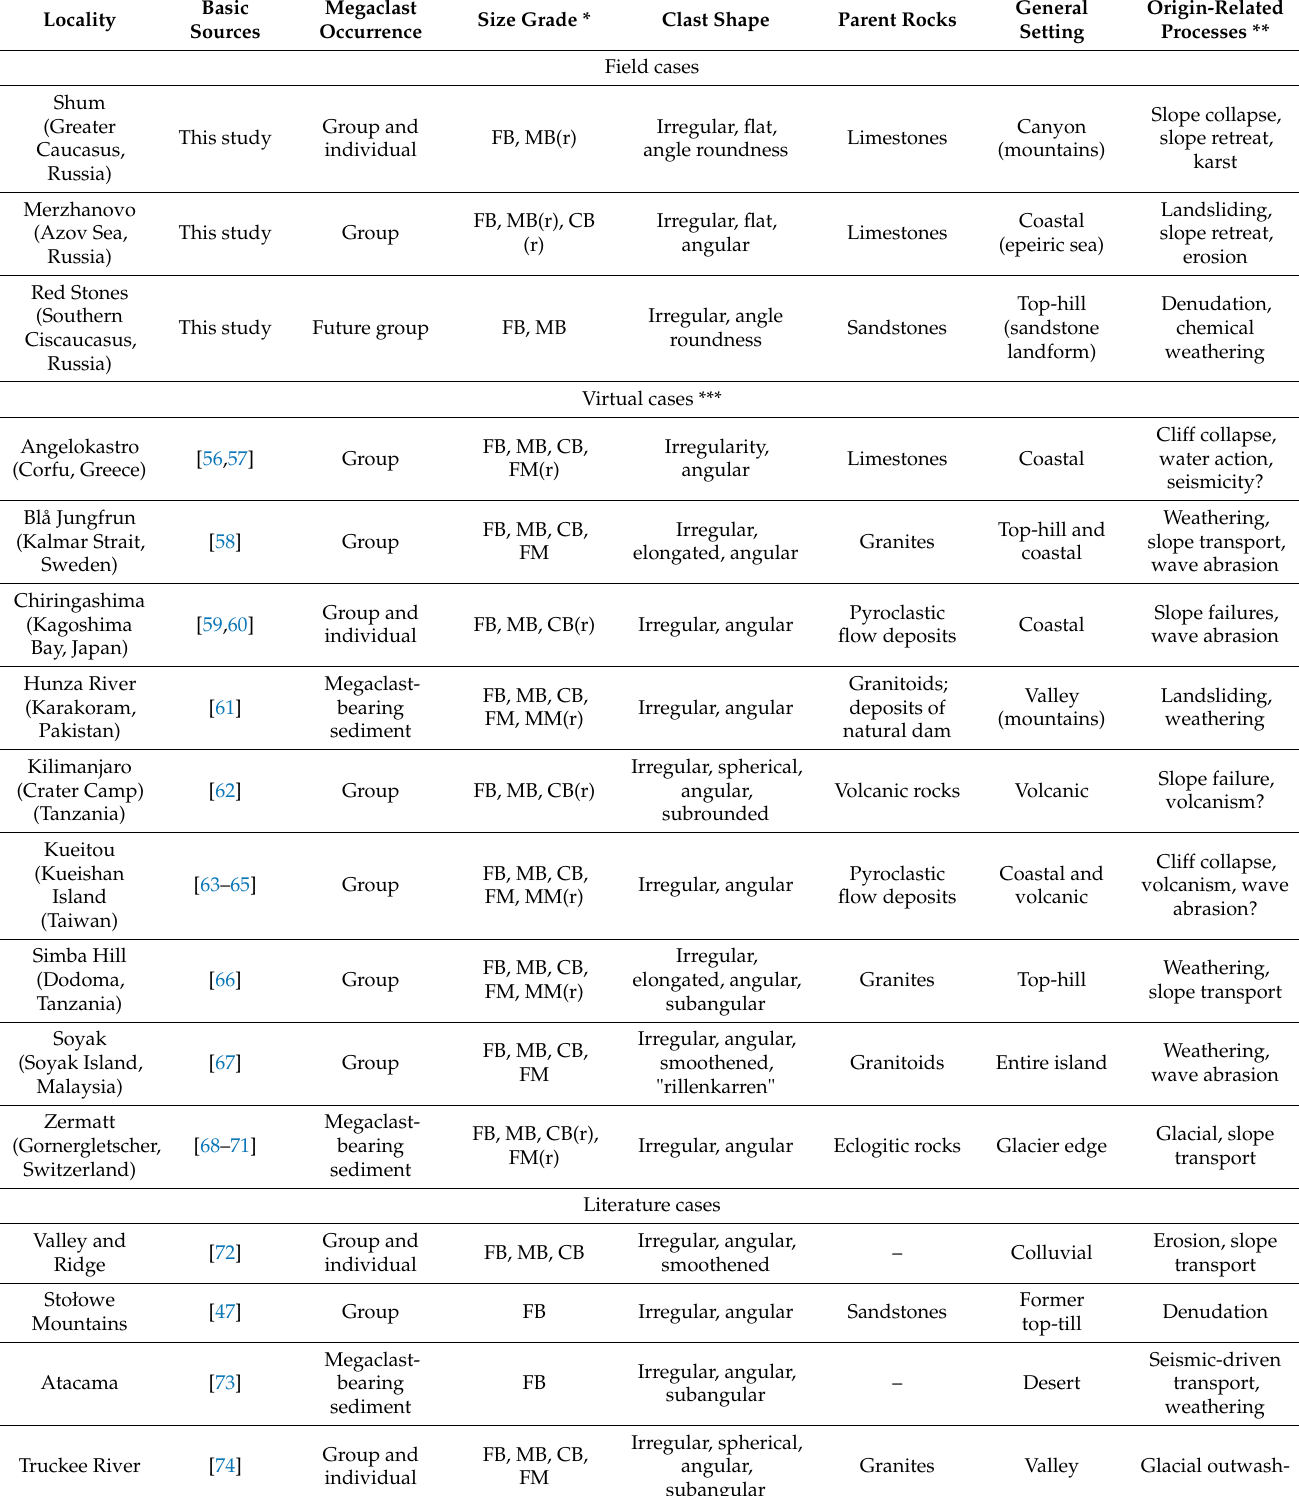
Table 2. Summary of the origin-related information from the considered megaclast